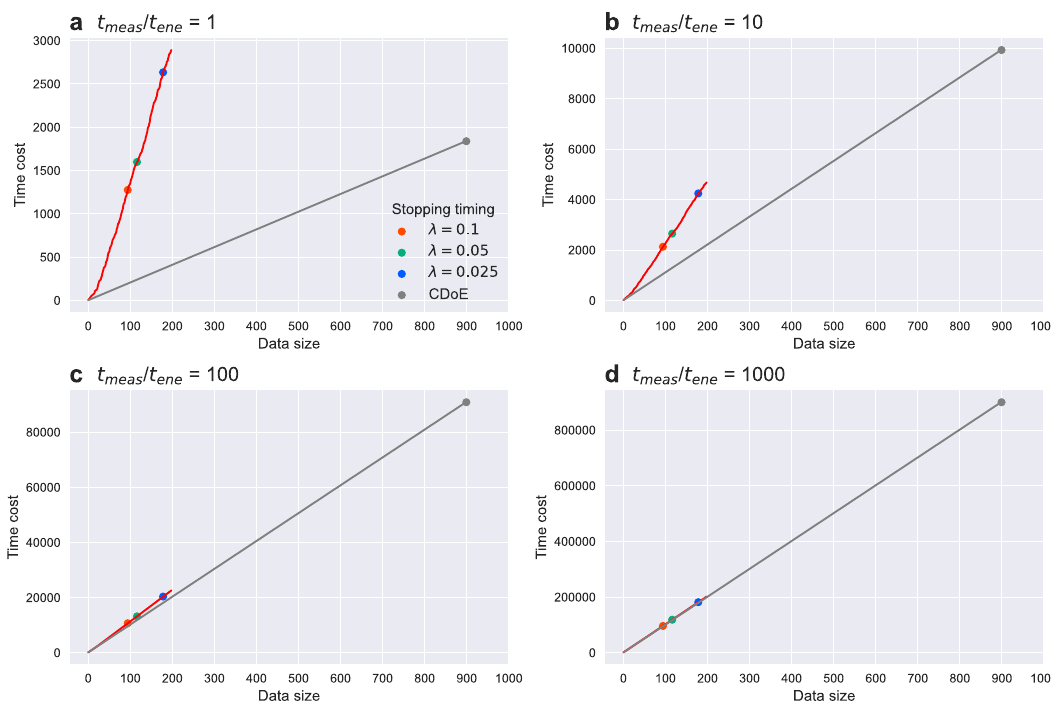
Fig. 5 Time cost estimation of the Ni L 2,3 XAS spectral measurement for simulated Ni 2 + . Time cost versus data size is plotted for various ratio between time to measure single spectral intensity t meas and time to change of unit energy t ene , a t meas / t ene = 1, b t meas / t ene = 10, c t meas / t ene = 100 and ( d ) t meas / t ene = 1000, respectively. Red and grey curves indicate time cost for the spectral measurement with AL and that with conventional DoE, respectively. Red, green, blue and grey circles indicate time cost at stopping timings of λ of 0.1, 0.05 and 0.025, and the conventional DoE